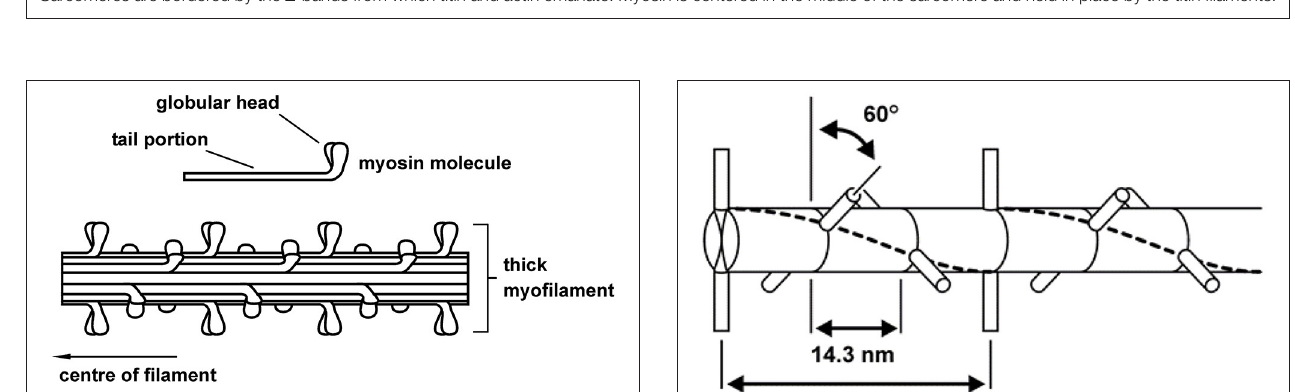
FIGURE 3 | Schematic representation of a skeletal muscle sarcomere. Shown are the contractile filaments actin and myosin and the structural protein titin. Sarcomeres are bordered by the Z-bands from which titin and actin emanate. Myosin is centered in the middle of the sarcomere and held in place by the titin filaments.